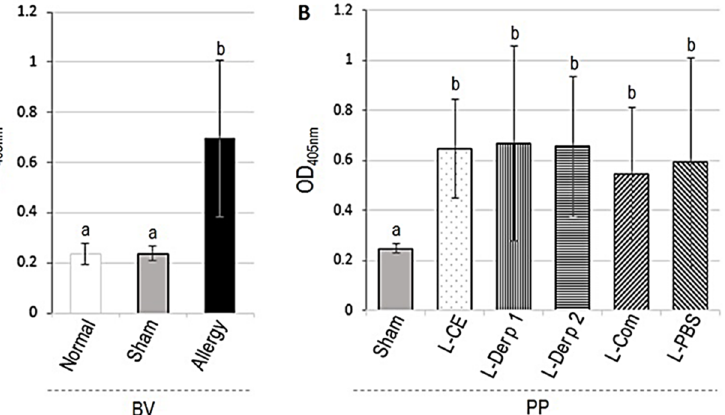
Fig 1. Indirect ELISA OD 405nm (means ± SD) of Dp-CE-specific IgE in sera of allergenizedmice comparedto sham and normalmice (A) before receivingvaccines/placebo (BV). (B) PP, Dp-CE-specific IgE in sera of allergicmice after treatment with vaccines (L-CE, L-Der p 1, L-Der p 2, and L-Com) and provokedwith aerosolic Dp-CE comparedwith placebo(L-PBS) and sham mice. Bars with different superscripts of BV or PP were different at p (cid:20)